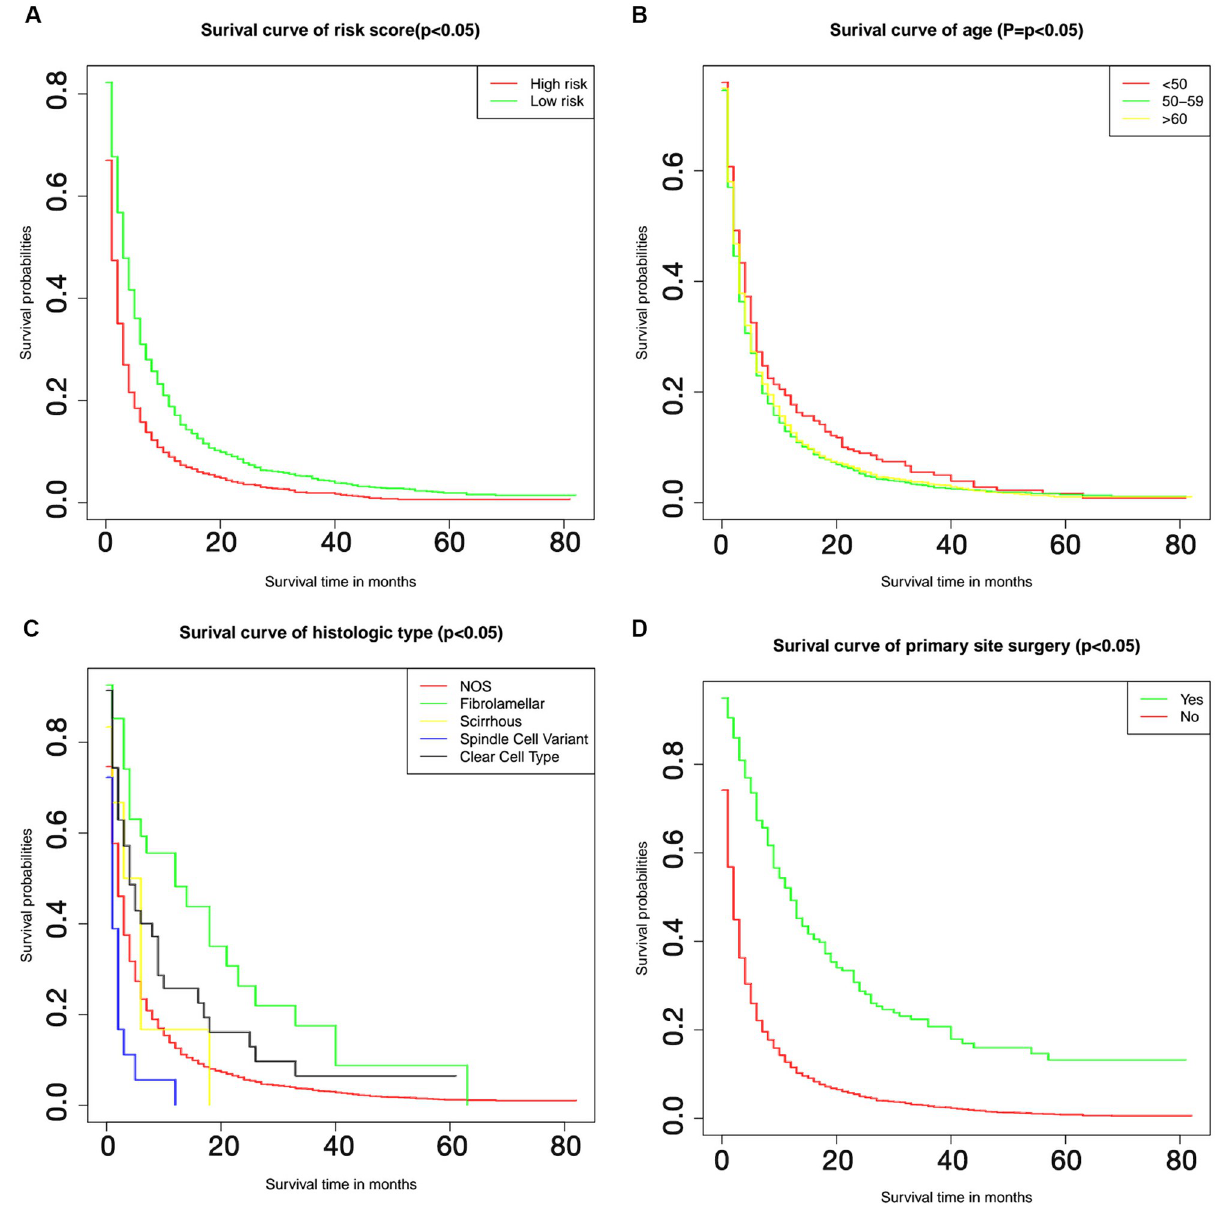
Fig 3. Kaplan-Meier curves based on different factors. The Kaplan-Meier survival curves show the differences on survival probabilities within high and low risk (A), among three age groups (B), among five histologic types (C) and whether received primary site surgery or not (D). than lung metastasis, within the 20 months follow-up period, but the long-term prognosis was worse. Additionally, the comparison of OS between patients from different age groups with different metastasis patterns is illustrated in Fig 5; while the comparison of OS between patients from different metastatic site groups with different ages, is shown in Fig 6. From Fig 5, lung metastasis exhibited worse prognosis within 20 months among all patients and in patients above the age of 60. In patients age 51–60, lung metastasis had the worst prognosis before approximate 40 months, overweighted by bone metastasis after 40 months. Shown by Fig 6,